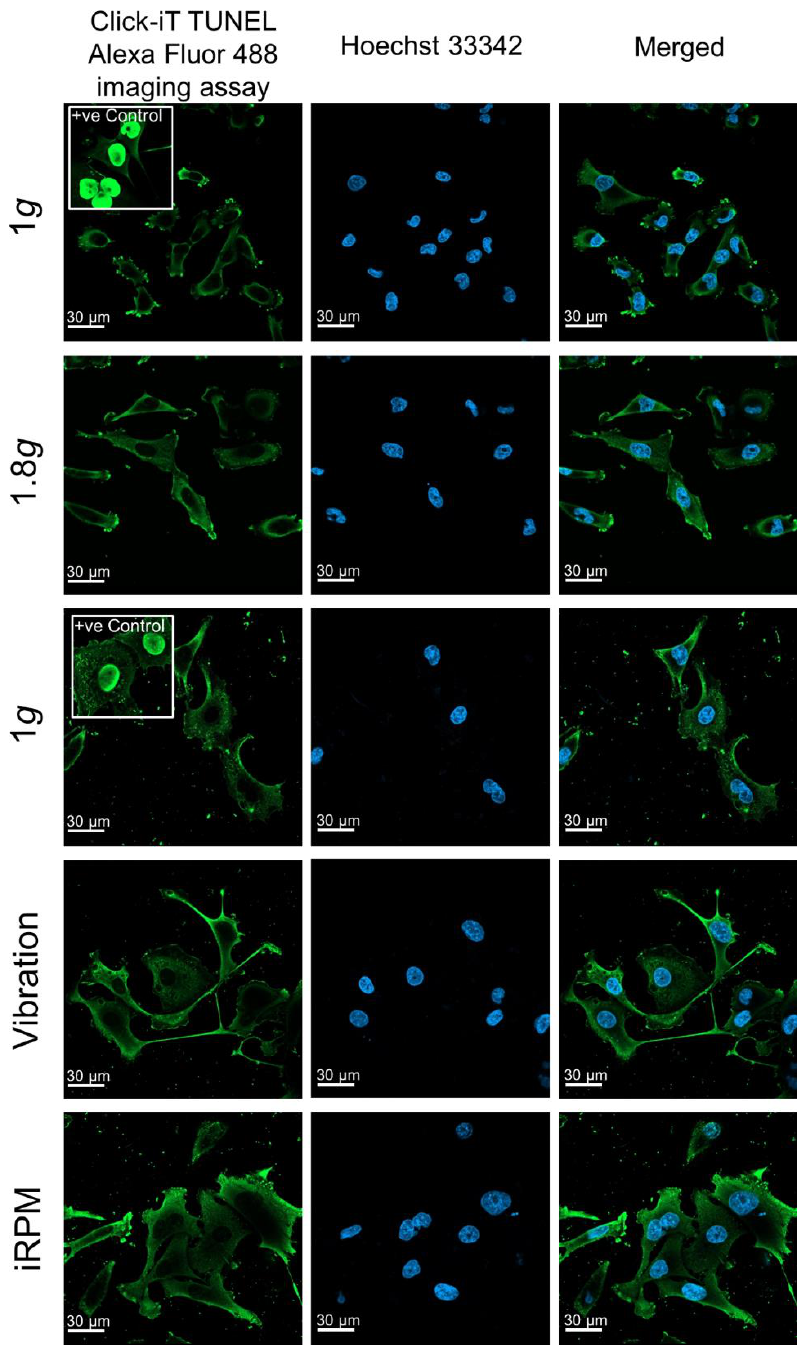
Figure 1. Click-IT terminal deoxynucleotidyl transferase dUTP nick end labeling (TUNEL) assay performed on MDA-MB-231 cells exposed to 1 g , 1.8 g hyper- g , vibration (VIB) and the incubator random positioning machine (iRPM). Green staining indicates free fluorophores in the cytoplasm in all images with the exception of the positive control. In the positive control, samples have been pretreated with DNase to induce DNA fragmentation, which is visualized by an enrichment of the fluorophores in the nucleus. Blue staining highlights the cells’ nuclei. Green stained nuclei present apoptotic cells as shown in the inserted positive controls. None of the applied experimental approaches had induced apoptosis in the cells.